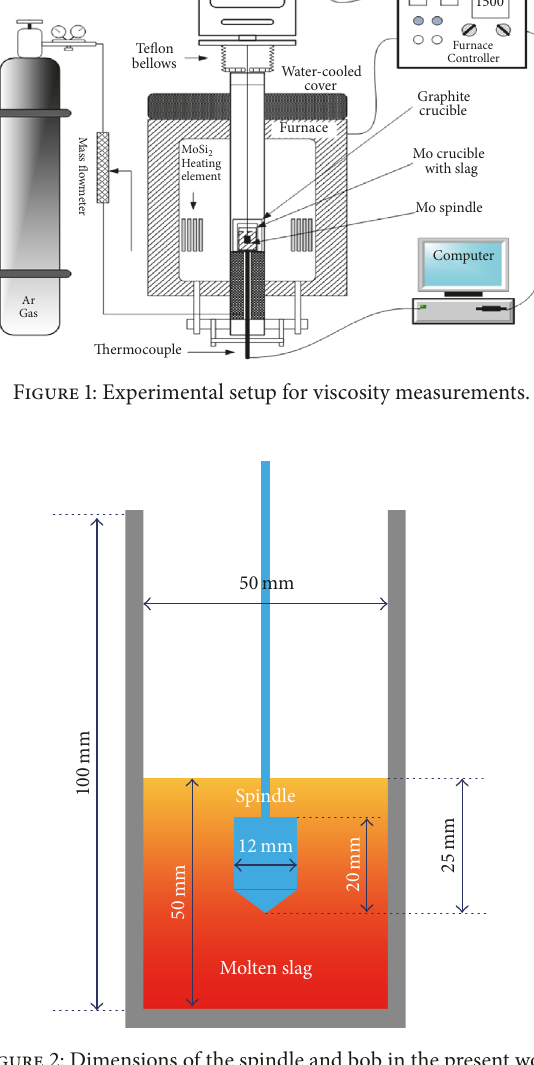
Table 1: Desired compositions in the present work.